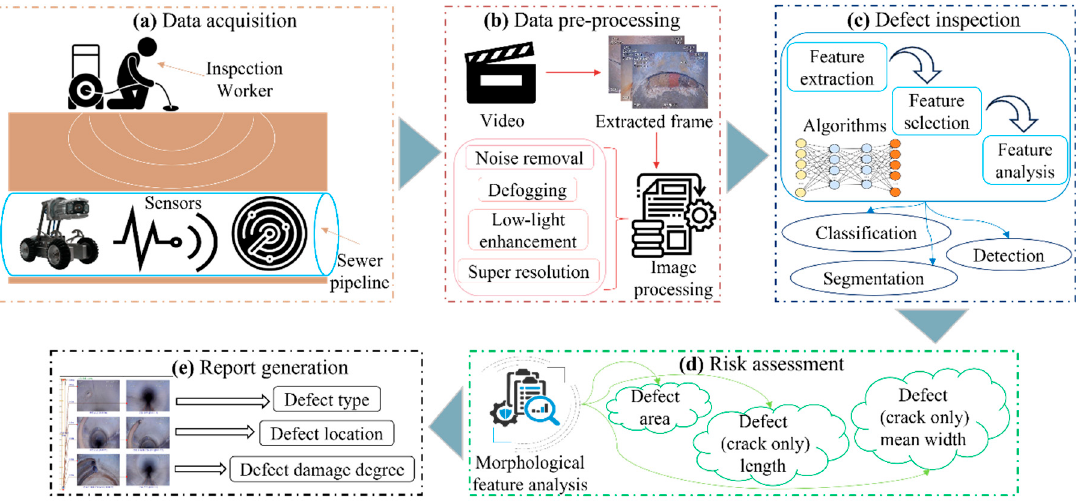
Figure 1. There are five stages in the defect inspection framework, which include ( a ) the data acquisition stage based on various sensors (CCTV, sonar, or scanner), ( b ) the data processing stage for the collected data, ( c ) the defect inspection stage containing different algorithms (defect classification, detection, and segmentation), ( d ) the risk assessment for detected defects using image post-processing, and ( e ) the final report generation stage for the condition evaluation.